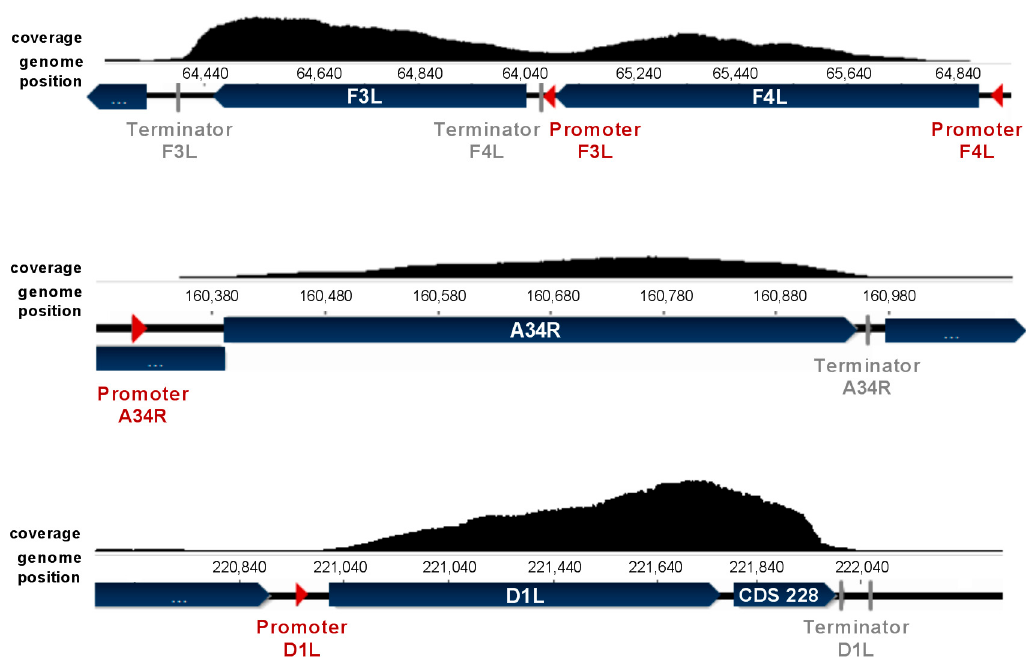
Figure 3. Coverage of viral transcripts between predicted promoter and terminator sequence. The coverage of genes clearly correlates with the predicted promoter [23] and terminator [24] sequences. Pictures show exemplarily the coverage in the HEp-2-passaged CPXV preparation using protocol I.